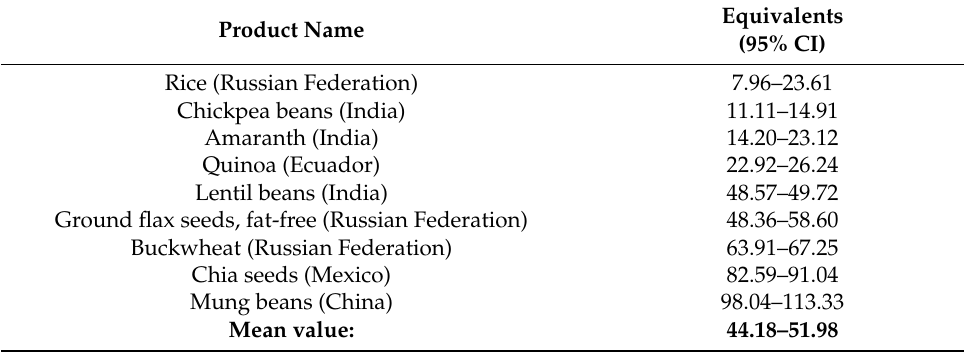
Table 4. ARP values for cereals, legumes, the seeds of plants, and the products of their